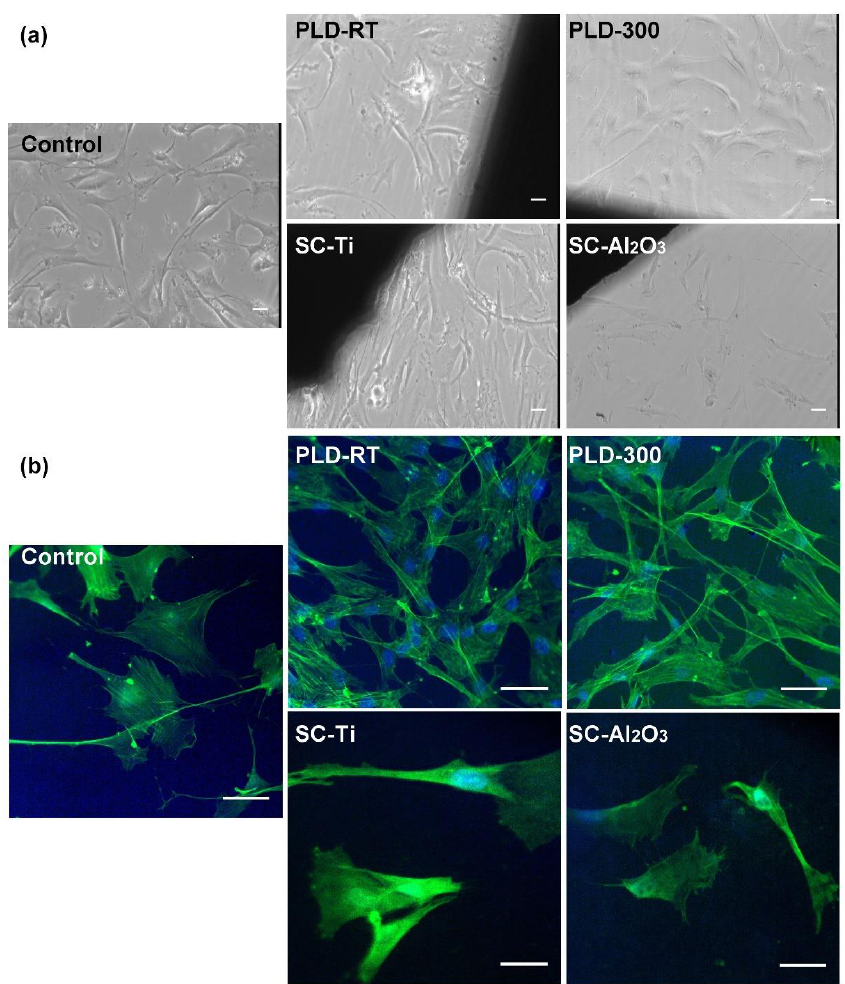
Figure 8. ( a ) Optical microscopy images and ( b ) fluorescence microscopy images of BJ cells grown on the coated samples compared to Control cells grown on glass slide. Scale bar is 10 μm for all images.